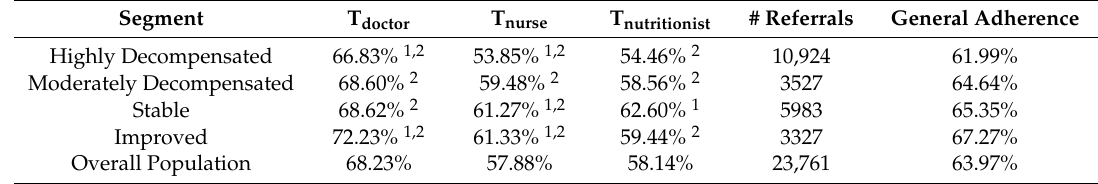
Table 5. Evolution segment adherence for grouped referrals from any discipline to a specific discipline.